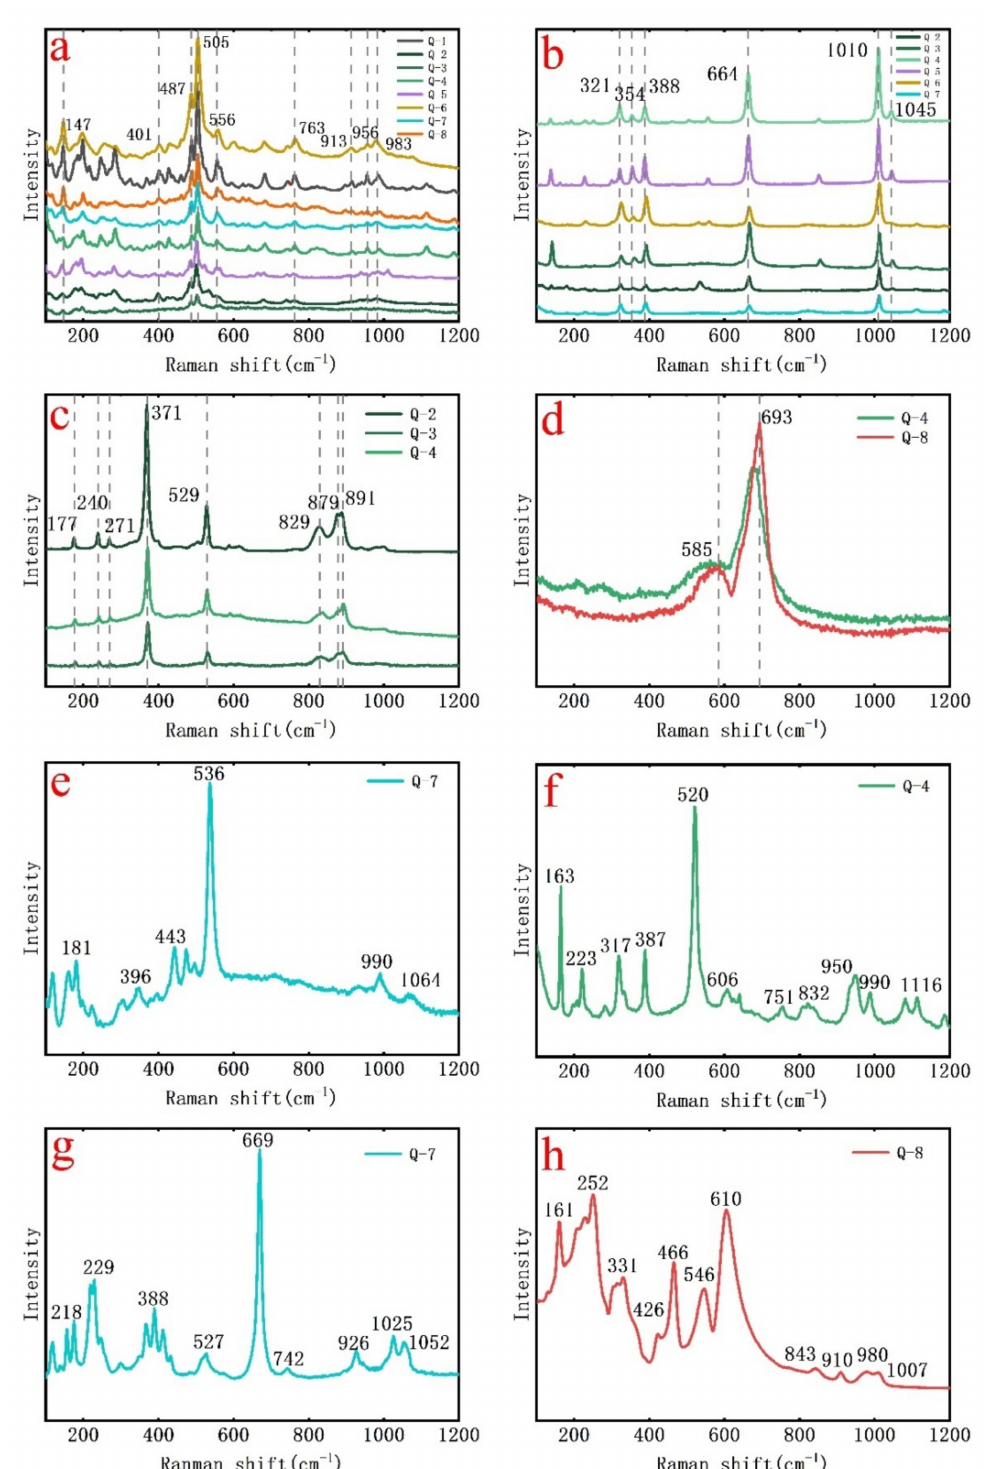
Figure 6. The Raman microprobe spectra for different minerals in the rock samples. ( a ) Anorthite; ( b ) diopside; ( c ) uvarovite; ( d ) chromite; ( e ) thomsonite-Ca; ( f ) prehnite; ( g ) tremolite; ( h )